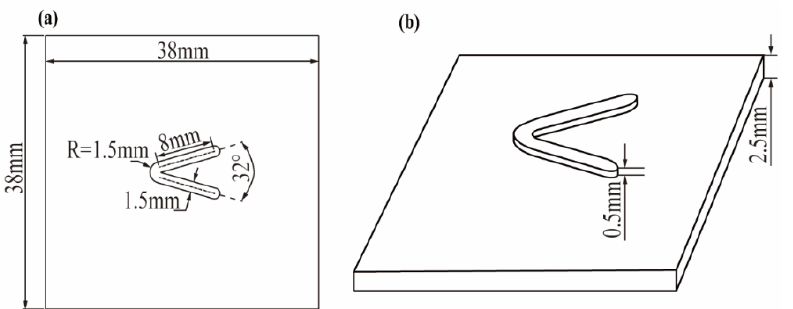
Figure 5. The design of a haptic pattern. ( a ) The size of angle stimuli; ( b ) The thickness of the haptic pattern.